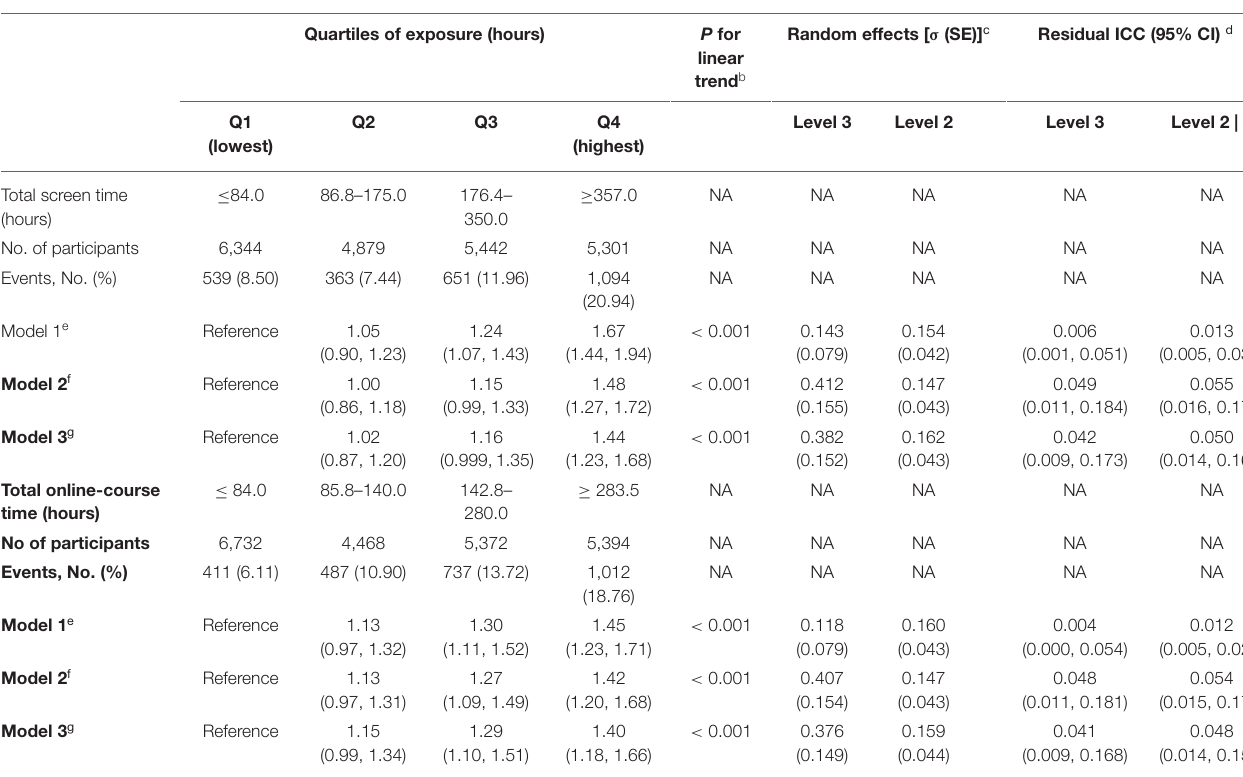
TABLE 3 | The associations [OR (95% CI)] of total screen time/online-course time with the risk of asthenopia a